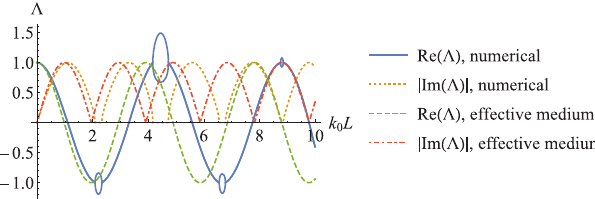
Figure 3. The imaginary and real parts of eigenvalues obtained from numerical results and effective medium calculations for the 9th order fractal MTM.